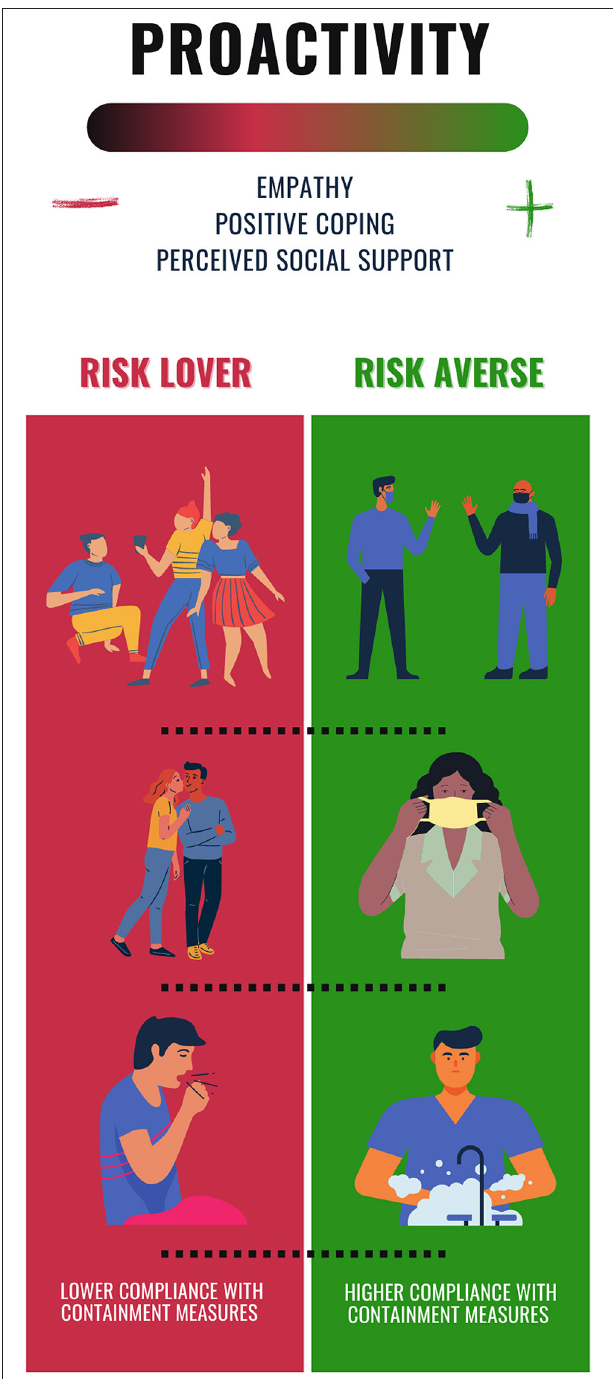
FIGURE 1 | Proactivity, risk-taking attitude and compliance with containment measures. The figure illustrates the relationship between Proactivity and risk-taking attitude toward negative health outcomes, and the possible consequences in the individual compliance with infection containment measures, in the context of Covid-19